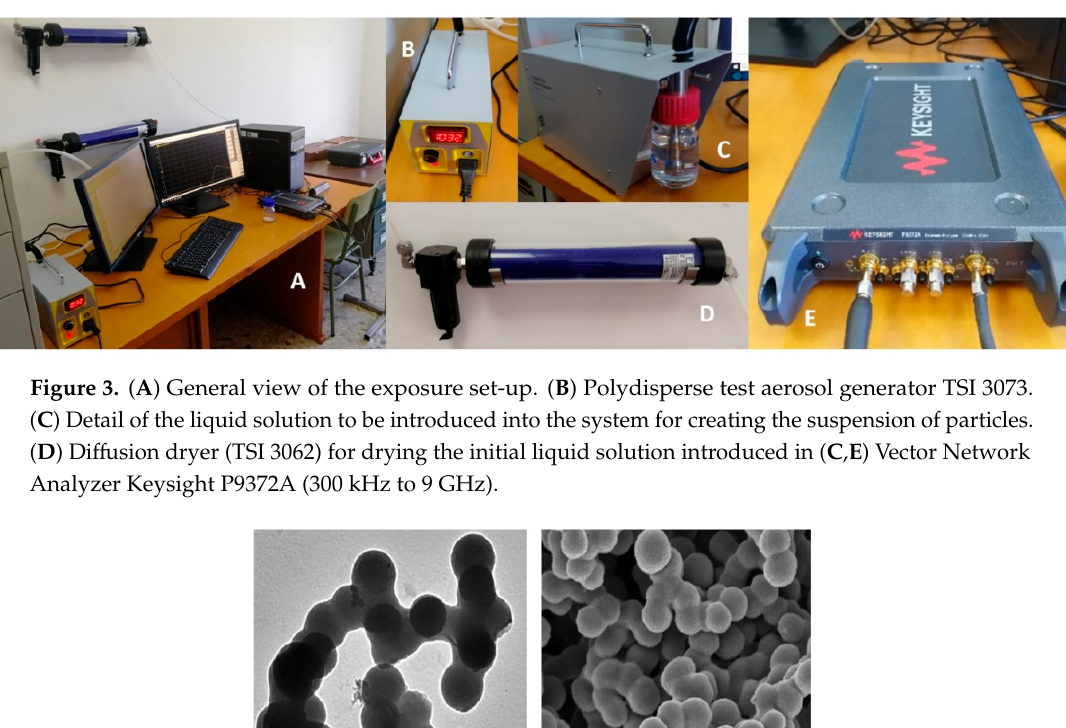
Figure 5. Detail of the particle counter PCE-PCO1 manufactured by PCE instruments. 3. Results